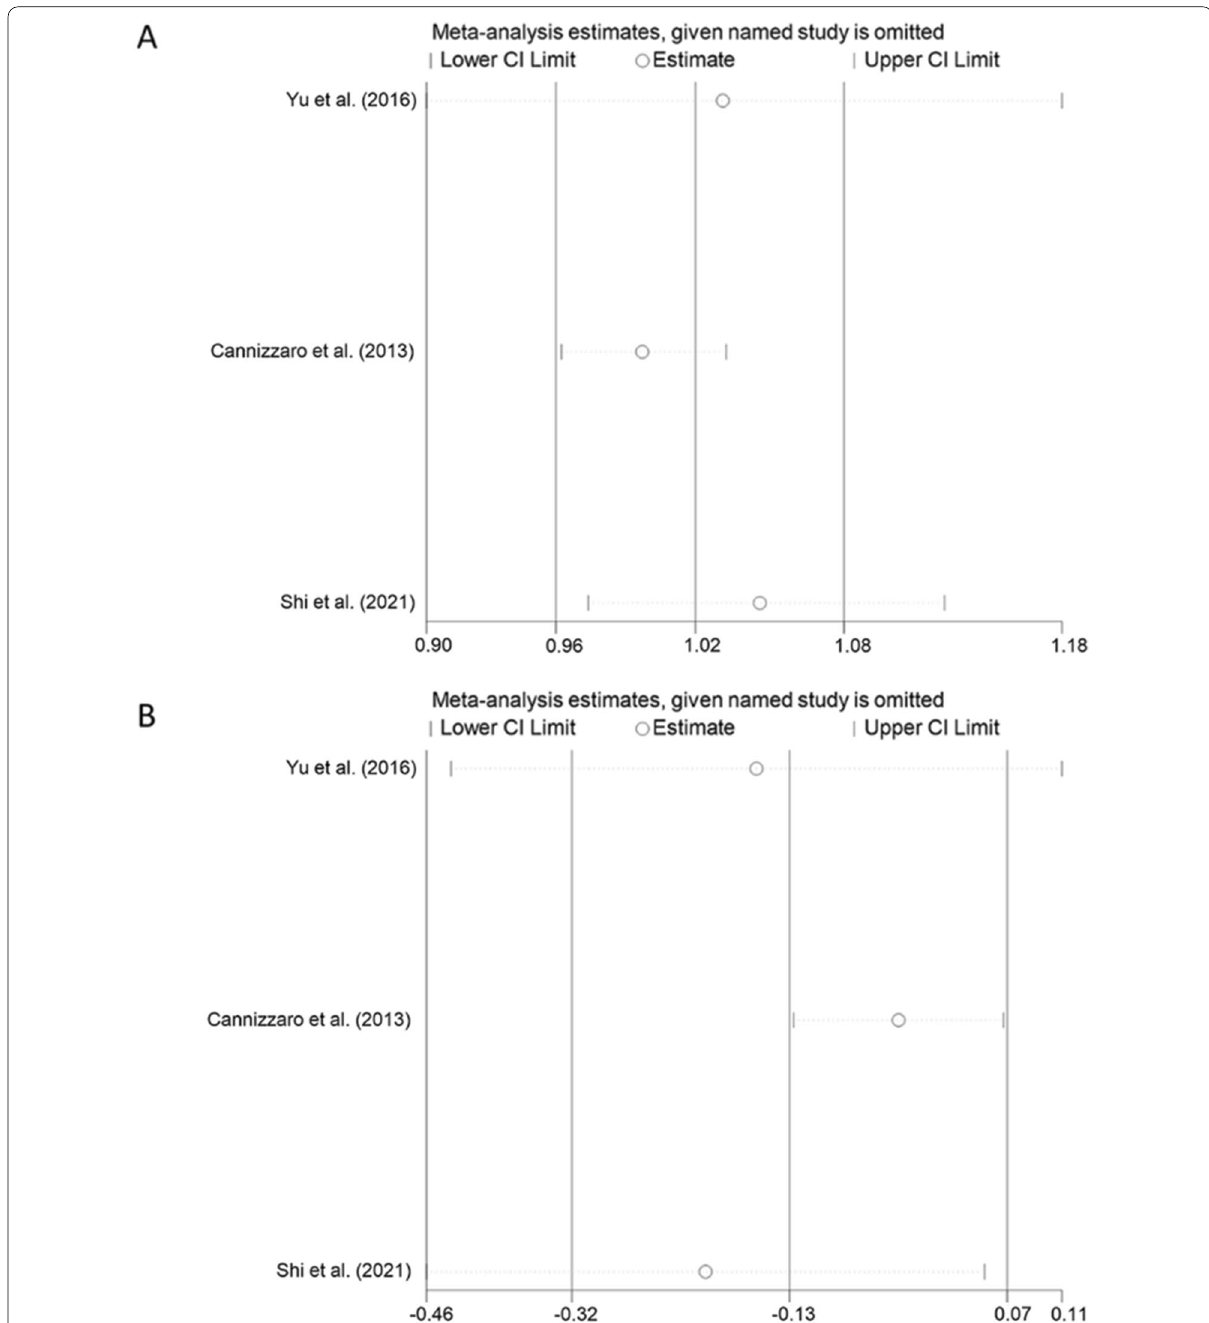
Fig. 4 Sensitivity analysis for the survival rate and MBL of RCTs. Sensitivity analysis ascertained the effect of each study on the overall estimate by removing each study in the meta-analysis. A Sensitivity analysis plot for the heterogeneity survival rate, showing that after omitting any included study, the 95% CI contained 1, so the results remained table. B Sensitivity analysis for the heterogeneity of marginal bone level changes, showing that after omitting any included study, the 95% CI contained 0, so the results remained table. CI confidence